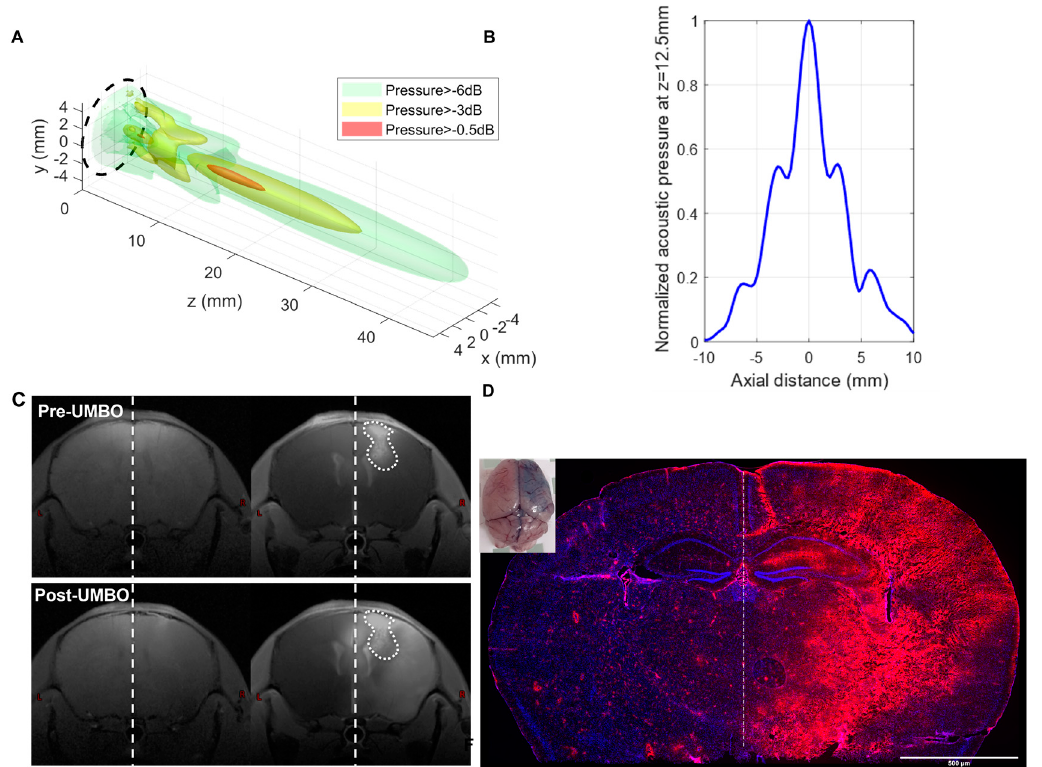
Figure 1. UMBO parameters are effective for BBB opening in healthy and Gl261 bearing mice. (Panel A , B ): 3D structure of the ultrasound waves generated by the calibrated low-intensity ultrasound system. (Panel C ): T1W MRI showed a marked Gd contrast enhancement within an hour following UMBO. An enhancement of Gd following UMBO in mice ( n = 2, analysis of the Gd enhancement is shown in Supplementary Material, Figure S1C). The two top T1-MRI images were obtained before UMBO (pre-Gd left MRIs; and post-Gd). The two bottom T1-MRI images were obtained after UMBO (pre-Gd left MRIs; and post-Gd). UMBO is effective in C57BL/6 mice. right MRIs). (Panel D ): Evans blue staining was enhanced in sonicated brain hemisphere compared to the control hemisphere vis- ually and by fluorescence ((Panel D ); Evans blue in red, DAPI in blue).